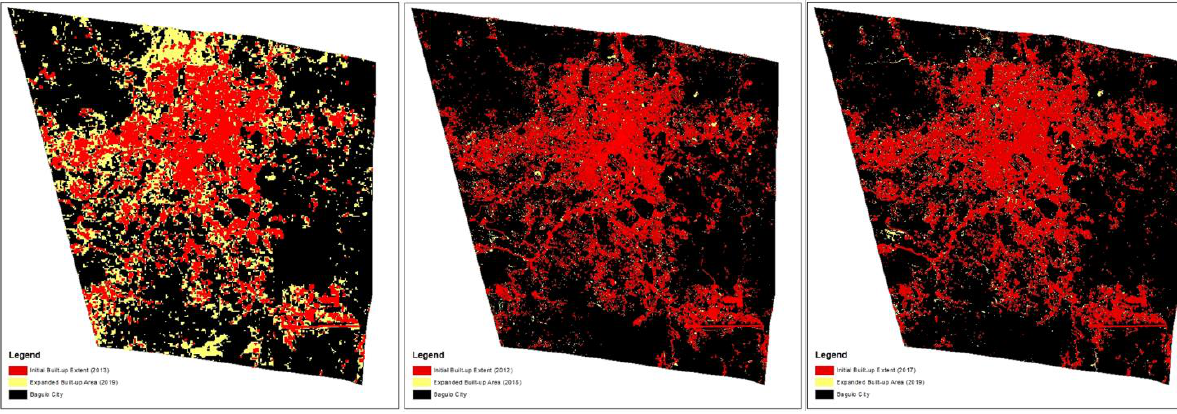
Figure 6. Side to side comparison of the built-up expansion maps generated for Landsat (right), RapidEye and PlanetScope